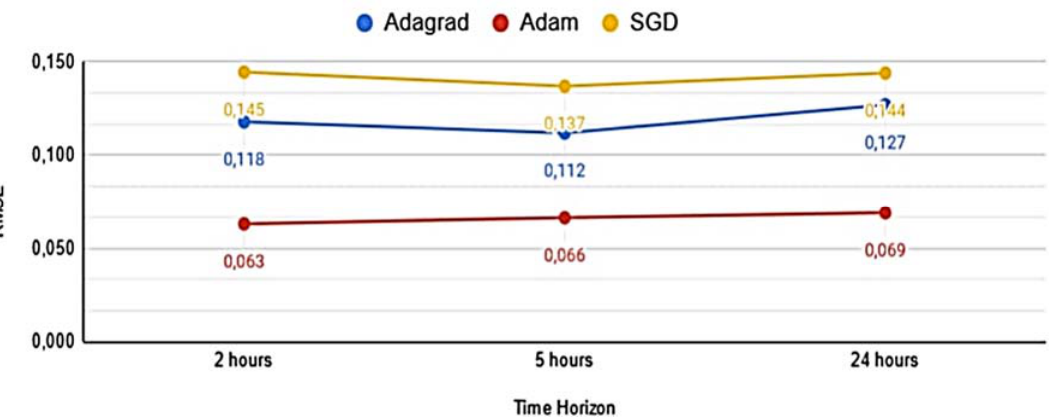
Figure 28. Average RMSE trend concerning prediction horizon by the optimiser for the validation set.